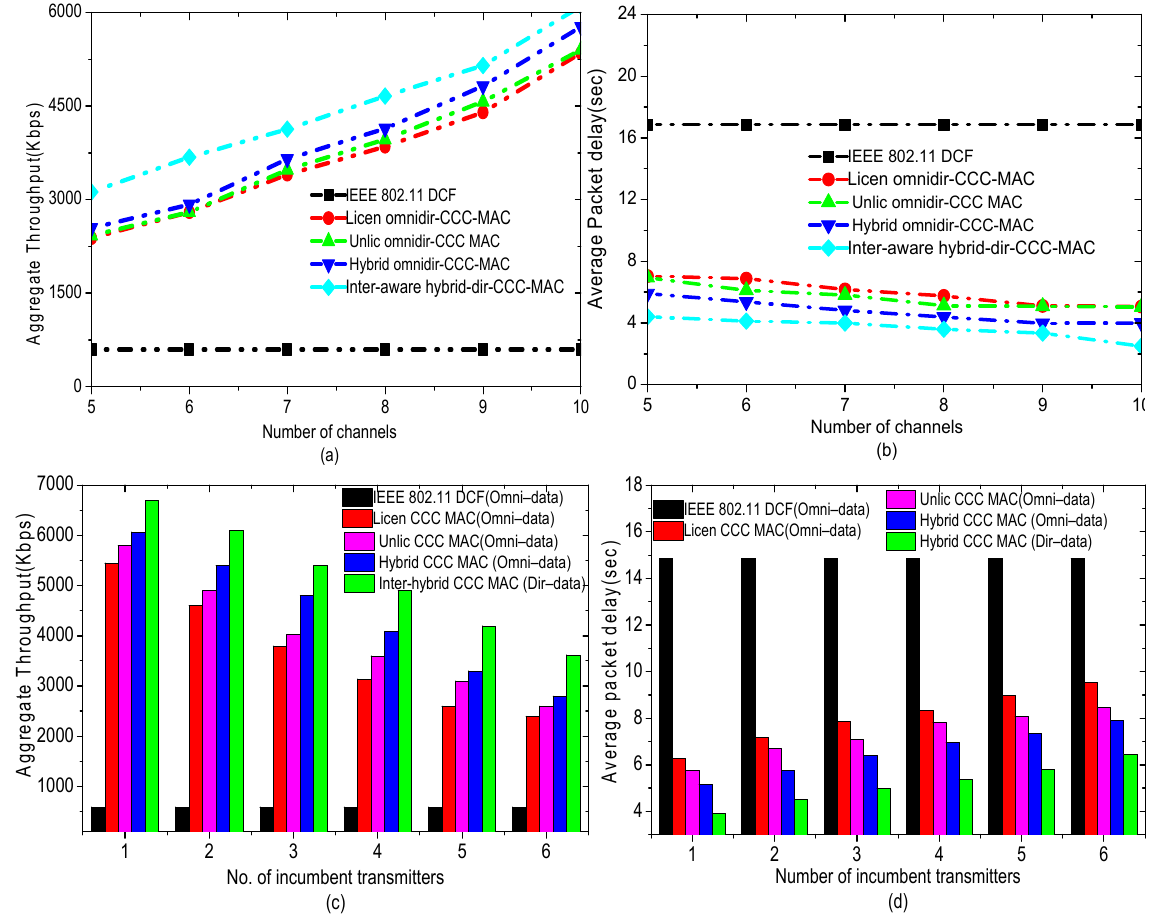
Figure 11. Aggregate throughput and average link delays calculation with number of channels and PU